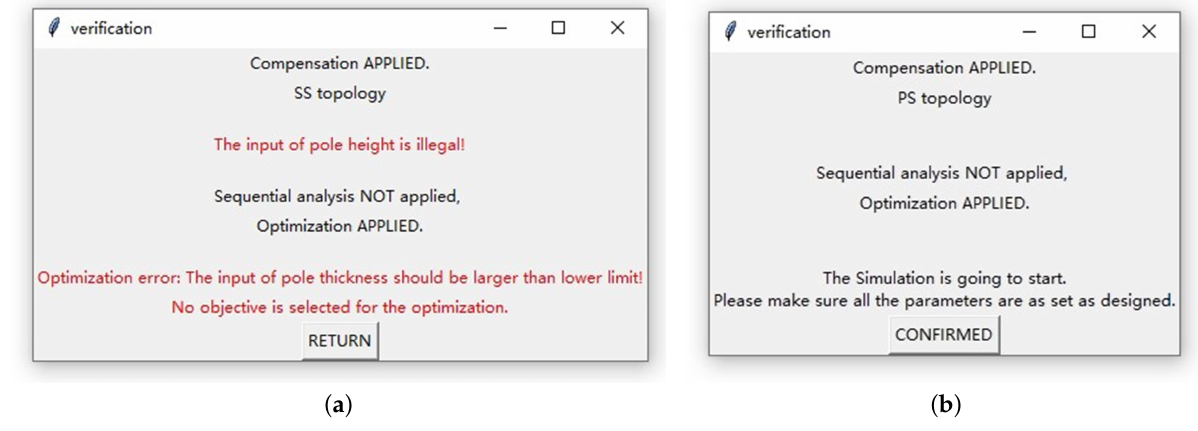
Figure 6. Pop-up validation window of ( a ) warning showing as red lines and ( b )